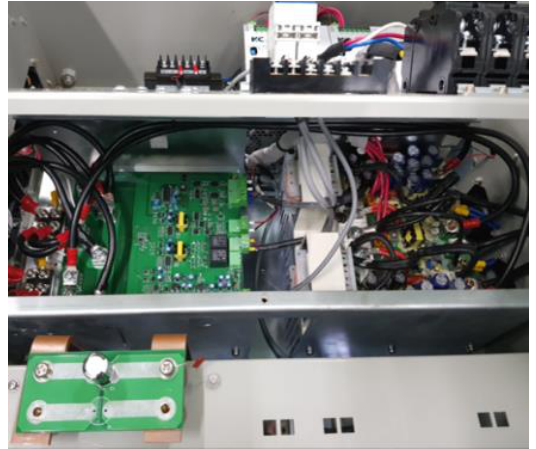
Figure 2. Photo of the electrical pitting prevention device.